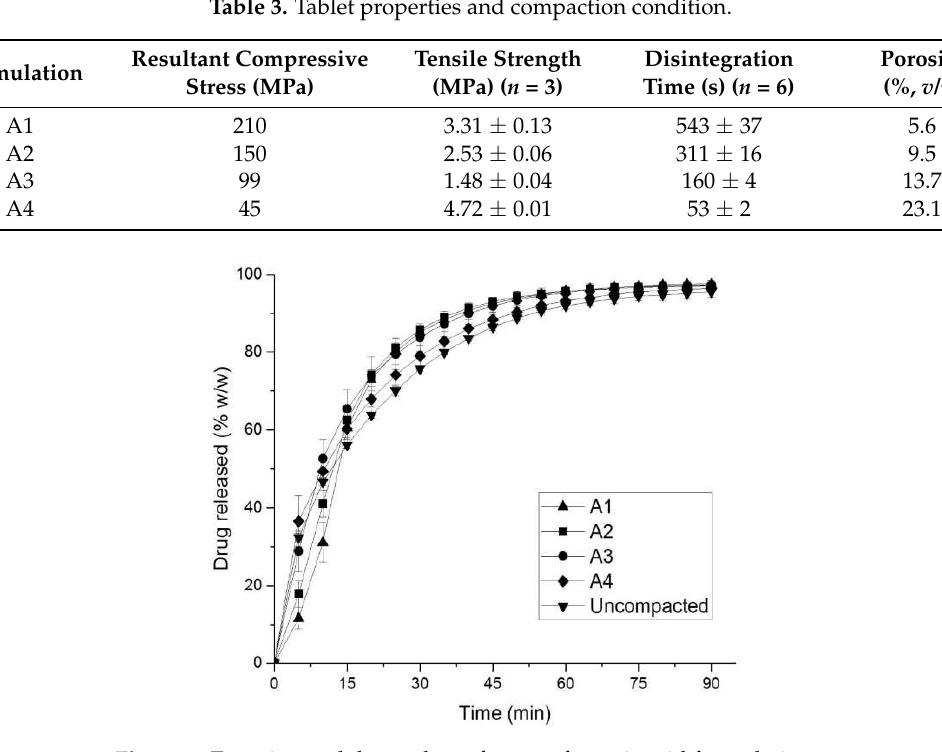
Table 4. Results of statistical analysis of dissolution rates at 10 min, 15 min, and 30 min for the formulations.